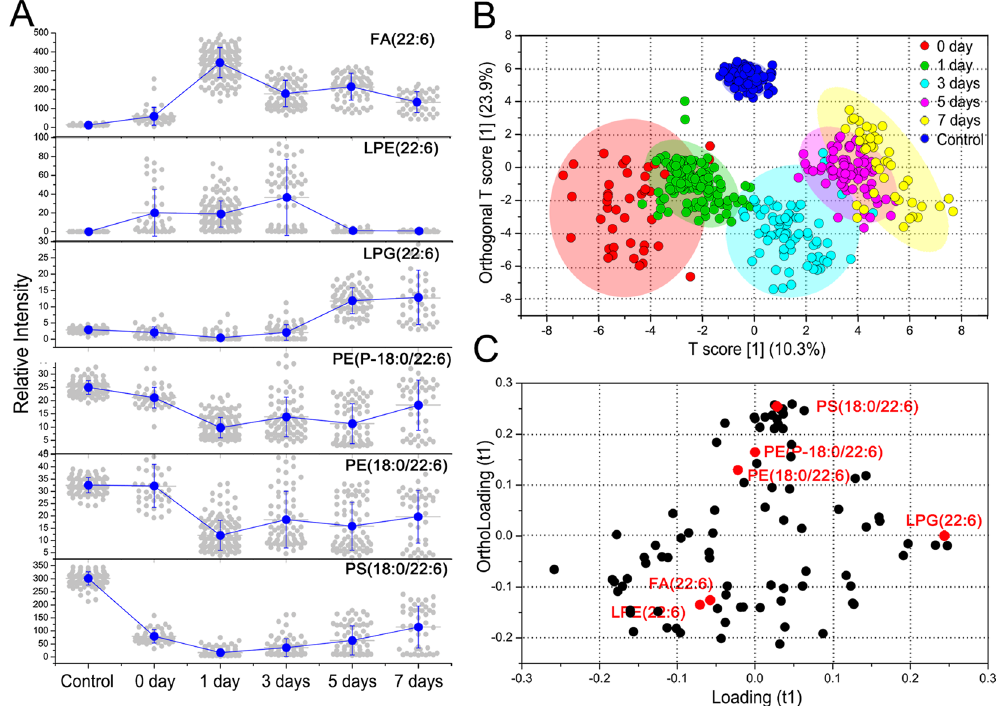
Figure 5. Statistic analysis for separation and feature selection of TBI groups with different time points and normal control. ( A ) Change tendencies of FA(22:6), LPE(22:6), PE(P-18:0/22:6), PE(18:0/22:6), and PS(18:0/22:6) in injury areas of TBI groups and normal control. ( B ) OPLS-DA score plots of lipids from the ROIs between normal control (blue) and TBI groups sacrificed at 0 day (red), 1 day (green), 3 day (light blue), 5 day (pink), and 7 day (yellow). ( C ) Loading plots of lipids from the TBI groups and normal control. DHA and DHA-containing lipid species were labeled in